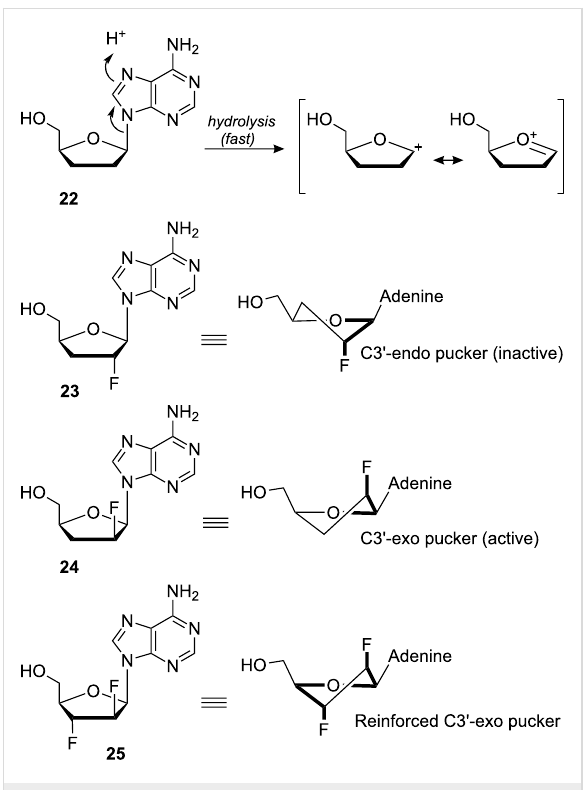
Figure 4: HIV reverse transcriptase inhibitor 22 and acid-stable fluorin- ated analogues 23 – 25 . The F–C–C–O gauche effect influences the ring conformations of 23 – 25 .